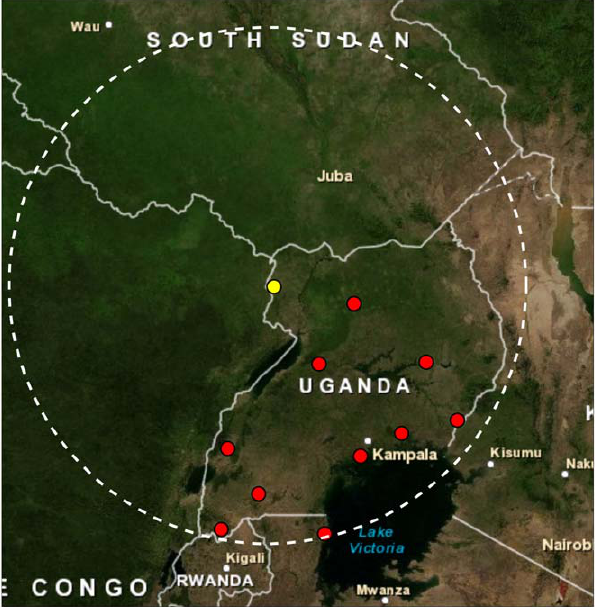
Figure 6. Map of meteorological stations within 500 km of Arua, Uganda. Meteorological stations containing rainfall data for at least 25% of the days between 1998 and 2010 (red circles) within 500 km of the Arua airport (yellow